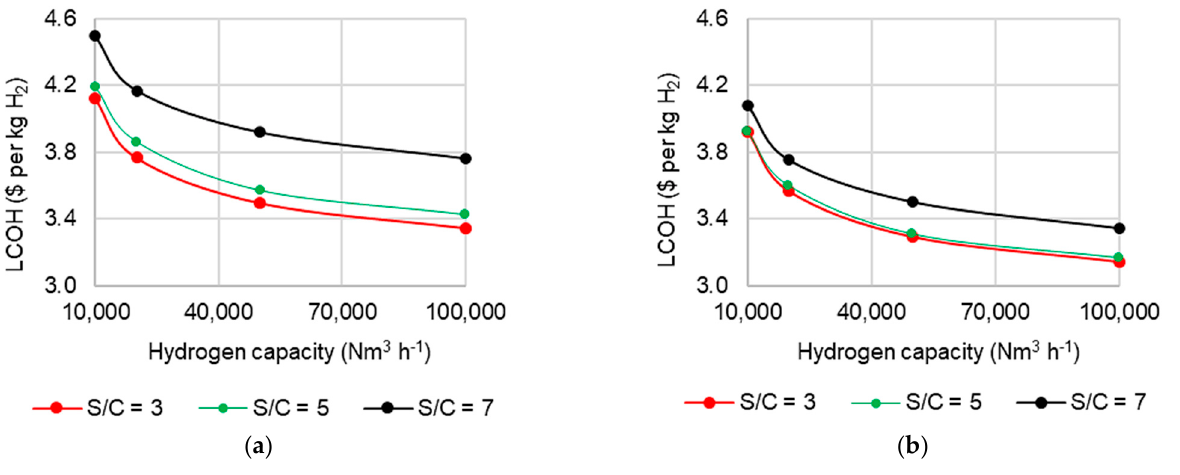
Figure 5. Effect of S/C ratio and capacity on levelised cost of hydrogen in C-SR at 30 bar and 900 °C ( a ) without steam export and ( b ) with steam export.